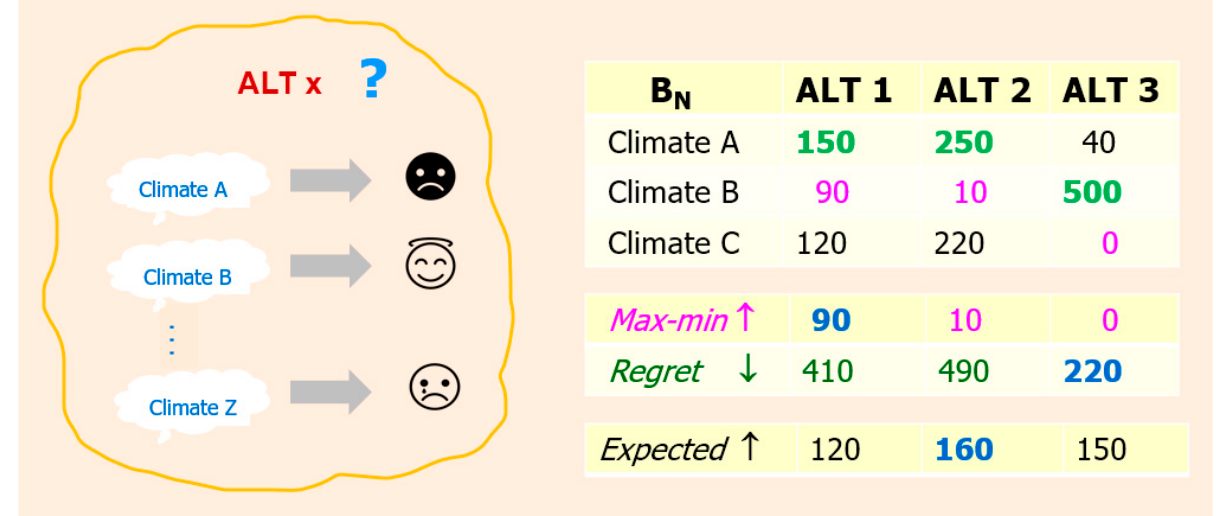
Figure 13. Deciding under uncertainty: different criteria are possible: ( left ) any ALTernative x may behave in different ways under different scenarios; ( right ) a simple case with three ALTs and three scenarios: according to the criterion adopted, the choice can be different (see text for explanations).